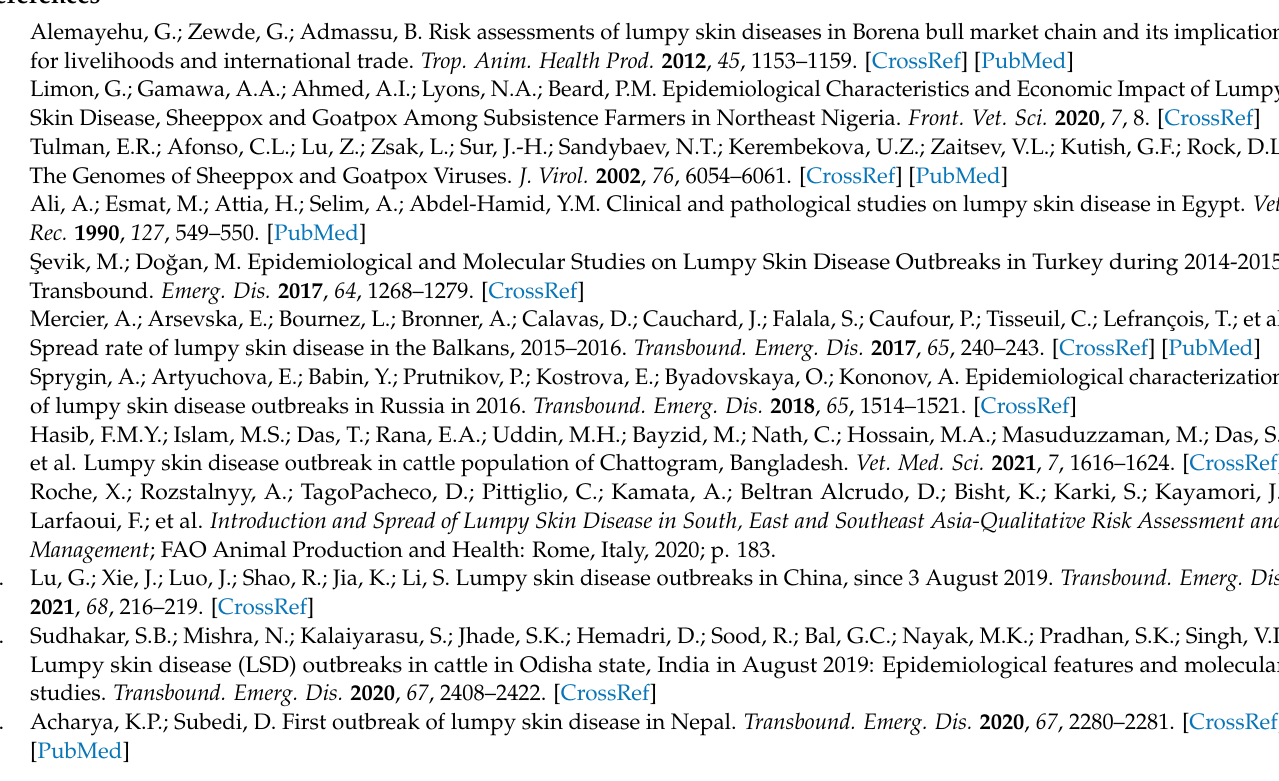
Table S1: Comparison of real-time PCR results (Ct values) between pan capripox real-time PCR, the new DIVA and the DIVA published by Agianniotaki et al. [28] for LSDV wild-type blood/organ- positive samples; Table S2: Comparison of real-time PCR results (Ct values) between pan capripox real-time PCR, the new DIVA, and the DIVA published by Agianniotaki et al. [28] Neethling-like vaccine-type positive organ samples; Table S3: Real-time PCR results (3 replicates) of samples containing different combinations of Neethling-like vaccine strain/classic or recombinant LSDV in different